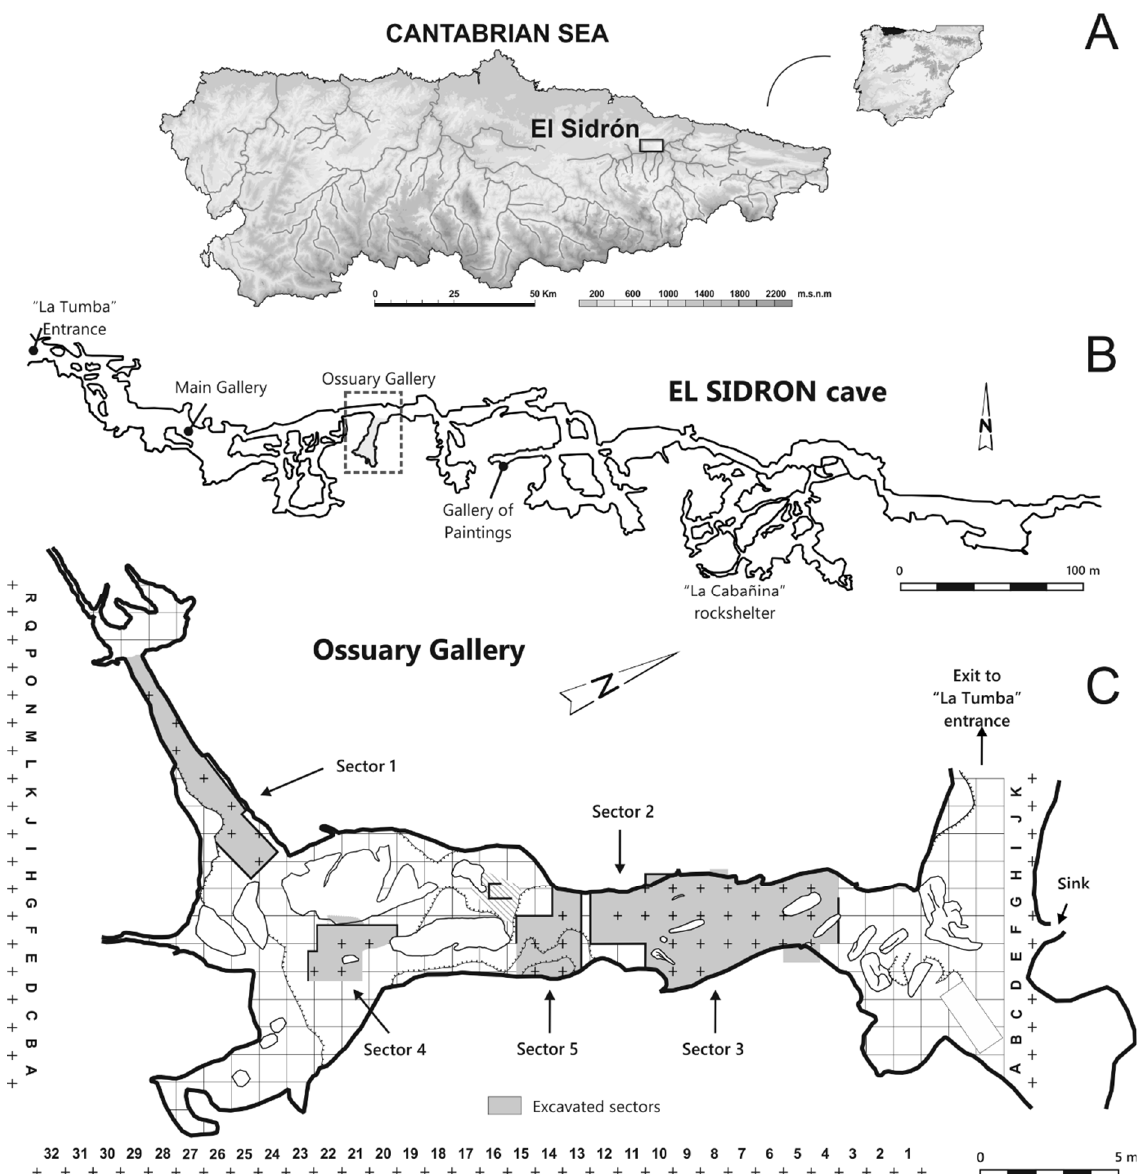
Figure 1. El Sidrón cave: ( A ) Geographical location of the El Sidrón cave; ( B ) cave map with the location of the main Figure 1. El Sidr ó n cave: ( A ) Geographical location of the El Sidr ó n cave; ( B ) cave map with the location of the main galleries; ( C ) excavation plan of the Ossuary Gallery. galleries; ( C ) excavation plan of the Ossuary